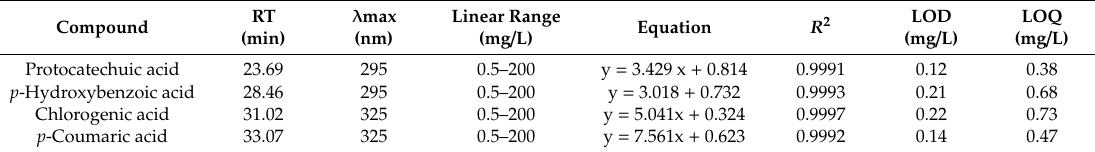
Table 6. Quantification parameters of the HPLC method used to quantity protocatechuic acid, p -hydroxybenzoic acid, chlorogenic acid, and p -coumaric acid after their USAE from AOR. λ max RT Linear Range Compound (min) (nm) (mg / L) Protocatechuic acid